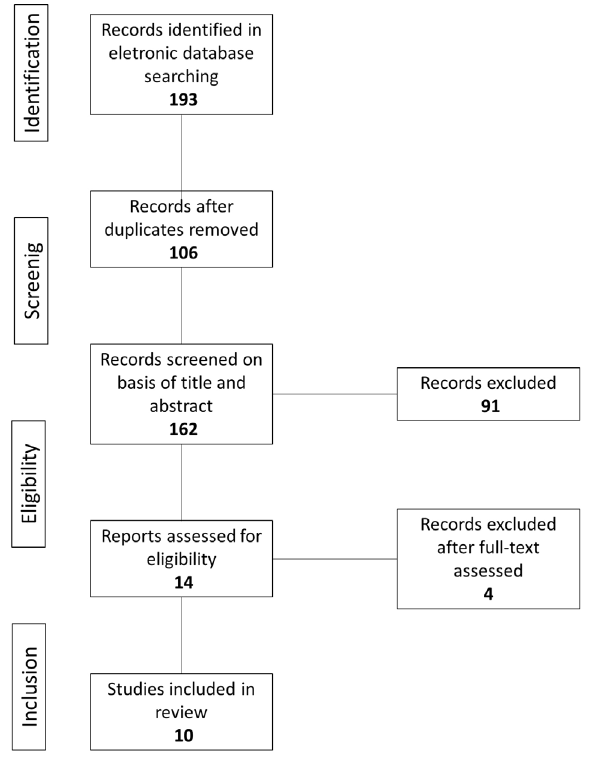
Figure 1. Flowchart of review process and study